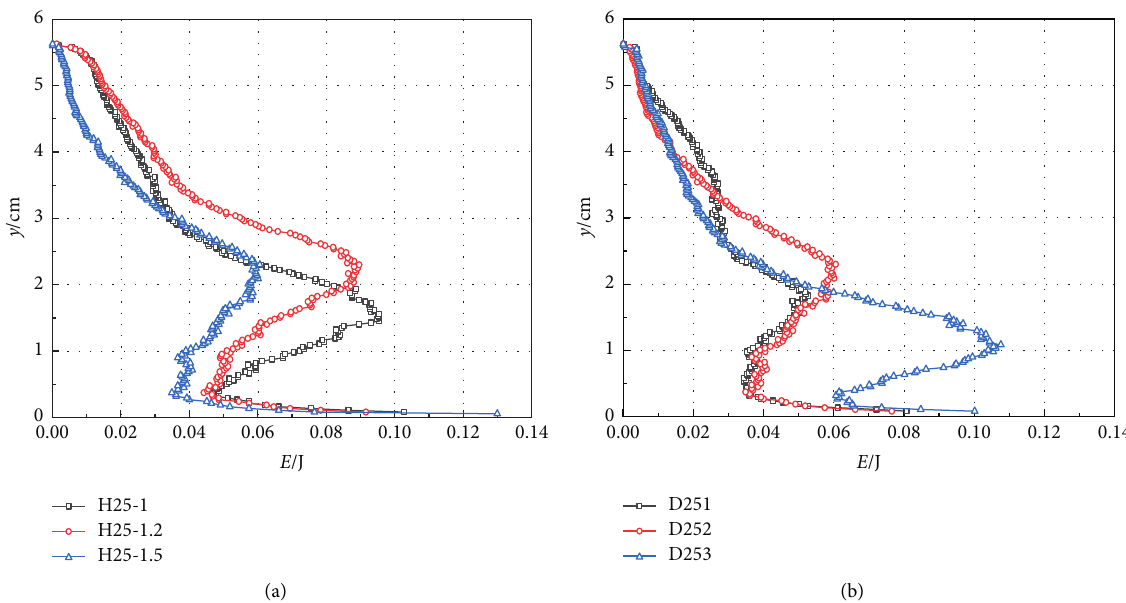
Figure 18: The vertical distribution of the kinetic energy in different working conditions ( x �